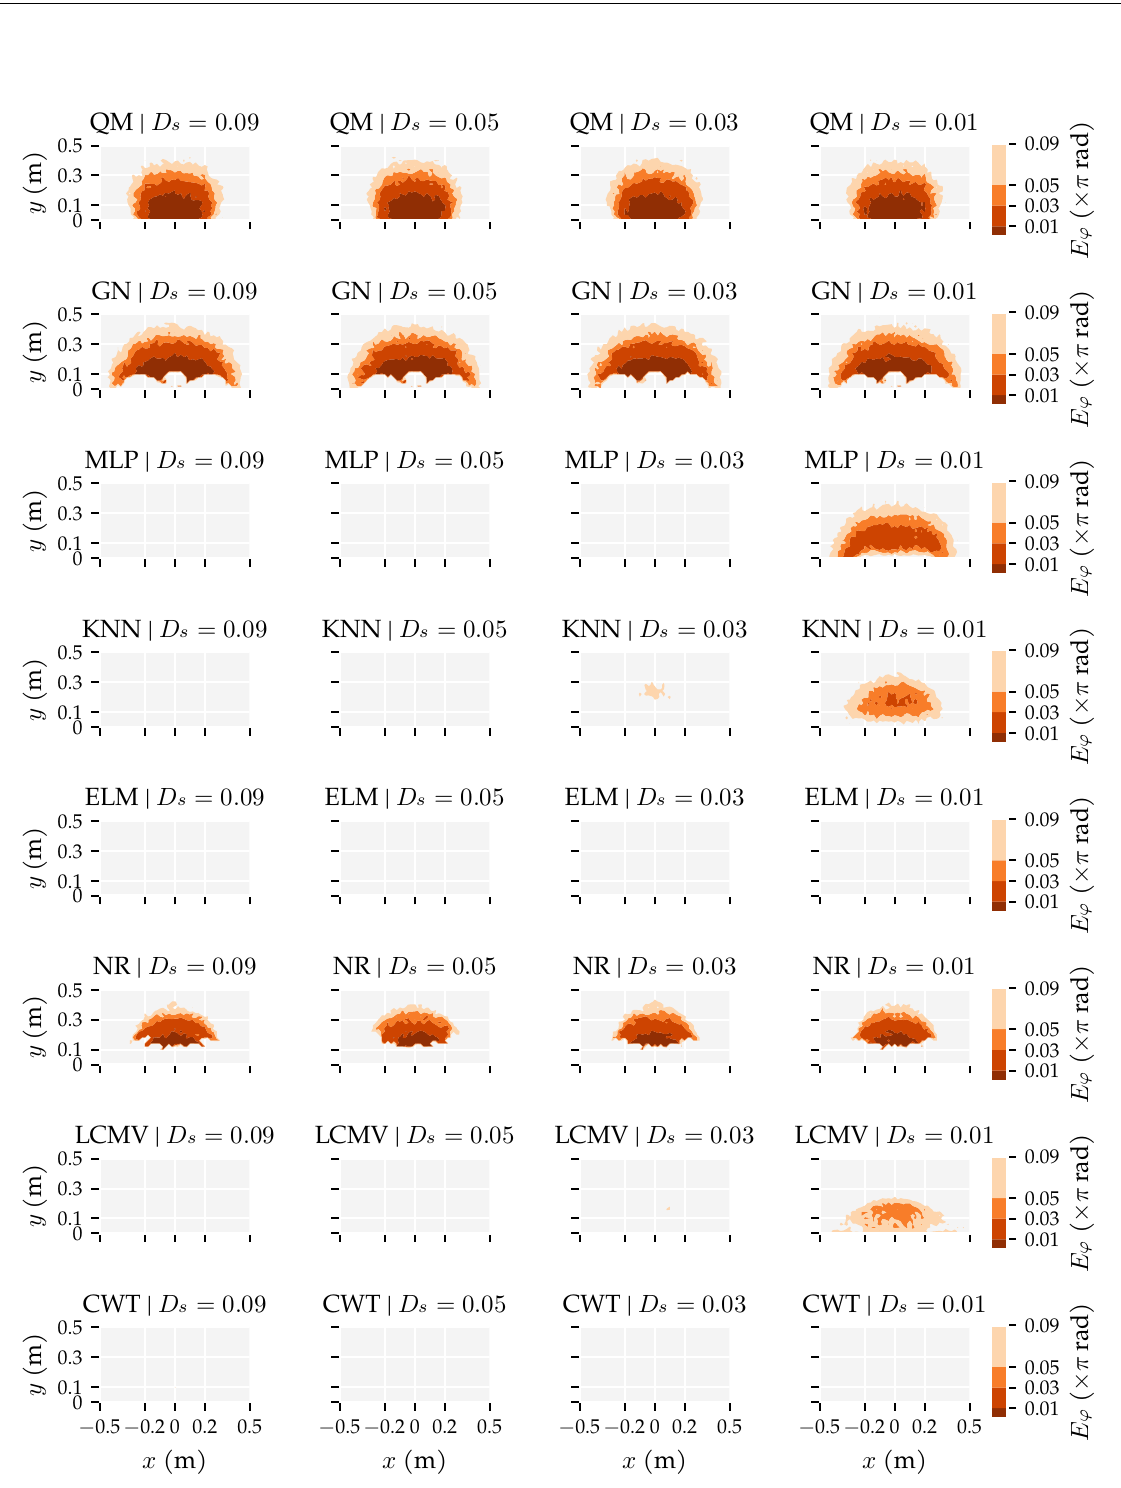
Figure A5. Spatial contours of the median movement direction error (Equation (5)) for each localisation algorithm in all conditions of Analysis Method 1. This analysis varied the minimum distance D s between sources in the training and optimisation sets (Table 1) while using the (x + y) sensor configuration at the σ = 1 × 10 − 5 ms − 1 noise level. The median movement direction error was computed in 2 × 2 cm 2 cells. The sensors were equidistantly placed between x = ± 0.2